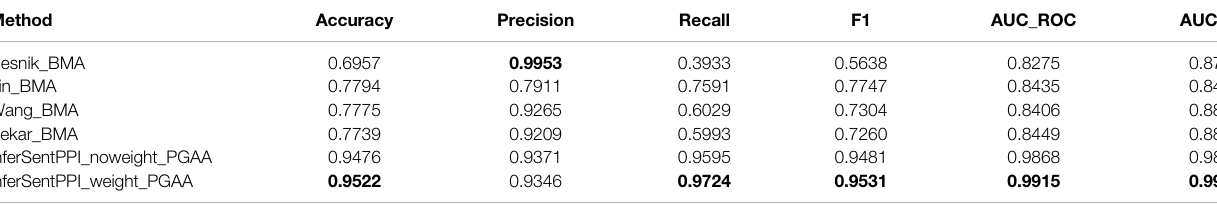
TABLE 2 | Performance comparison of six methods on the yeast dataset from DIP. Method Accuracy Precision